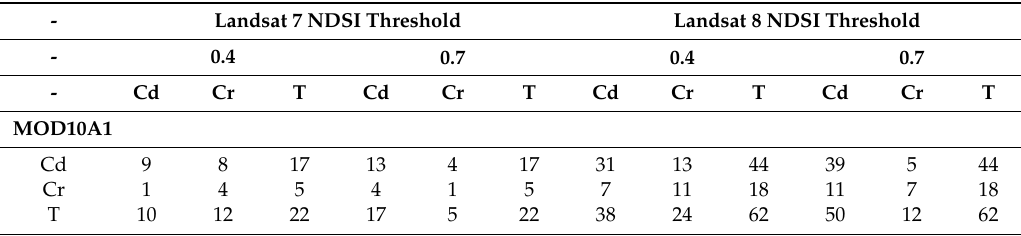
NDSI thresholds 0.4 and 0.7. Cd, Number of days classified as Cloud; Cr, Number of days classified